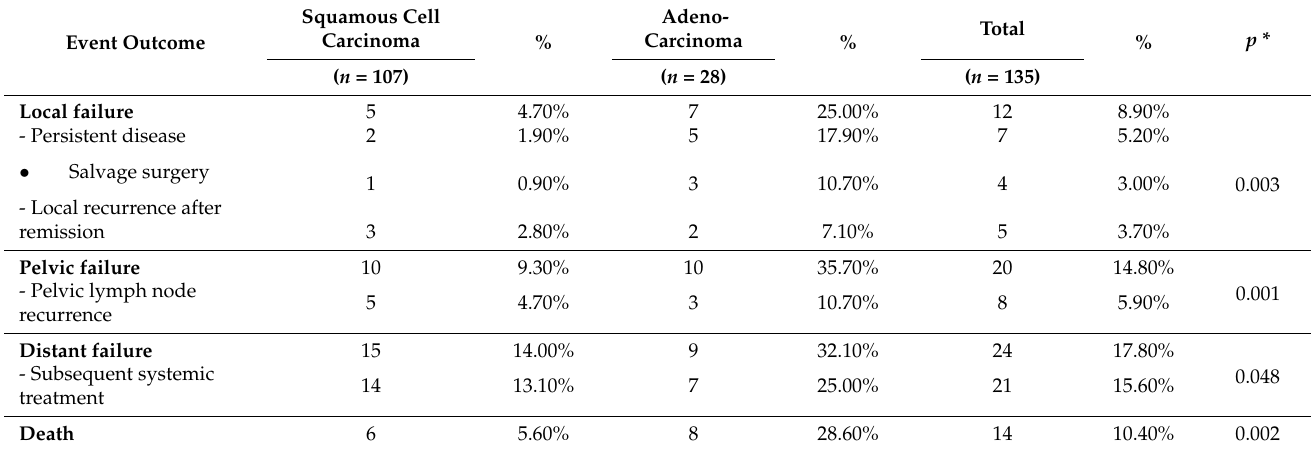
Table 3. Treatment outcomes of patients with brachytherapy for cervical